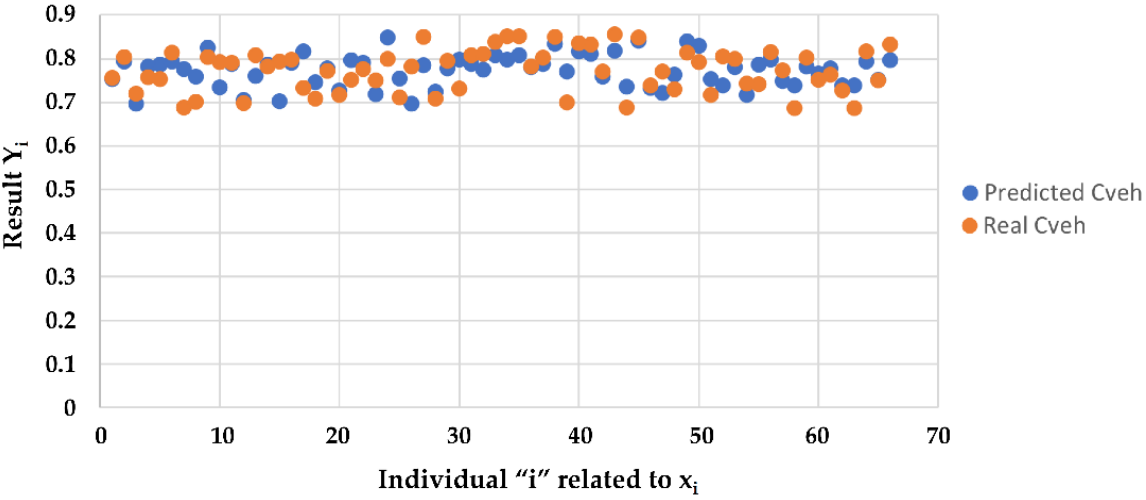
Figure 7. Coefficient C Veh : predicted v/s real values.